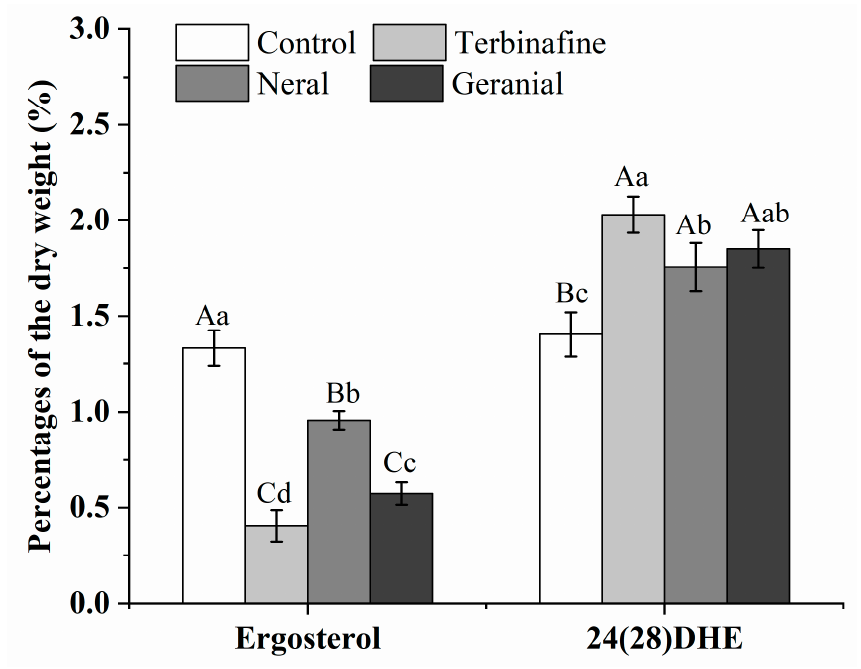
Figure 6. Sterol quantification of Trichophyton rubrum mycelium in different treatment groups at five days post-treatment. For ergosterol or 24(28)DHE, columns with lowercase or uppercase letters indicate significant or highly significant differences ( p < 0.05 or p < 0.01).